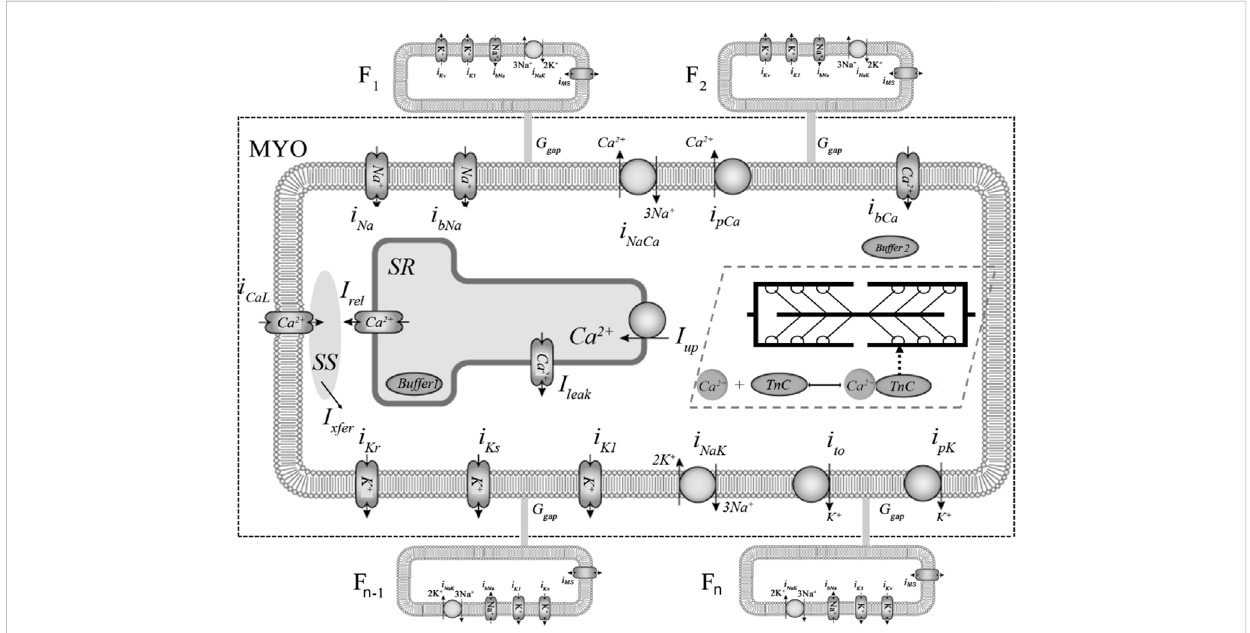
FIGURE 1 Ionic membranecurrents and intracellular calcium homeostasisin the TP + M and fi broblast models. The fragment delimited bydashed rectangular box represents theelectrophysiologicalpart ofthecombined TP+ M model. The fi broblasts arelabelled F 1 , F 2 , ... ,F n-1 , F n .Calcium currents:L-typeCa 2+ current ( i CaL ) and background Ca 2+ current ( i bCa ). Potassium currents: inward recti fi er K + current ( i K1 ); transient outward current ( i to ); rapid and slow delayed K + recti fi er current ( i Kr , i Ks ); plateau K + current ( i pK ). Sodium currents: fast Na + current ( i Na ) and background Na + current ( i bNa ). Pumps and exchangers: sarcolemmal Ca 2+ pump current ( i pCa ); Na + -K + pump current ( i NaK ) and Na + -Ca 2+ exchanger (NCX) current ( i NaCa ). Calcium translocations: Ca 2+ release from the sarcoplasmic reticulum (SR) via ryanodine receptors into subspace (SS) ( I rel ); Ca 2+ diffusion from SS into cytoplasm ( I xfer ); a small Ca 2+ leakfromintoSRintocytoplasm ( I leak );Ca 2+ pumpingfromthecytoplasm to theSR( I up ),where Ca 2+ ispartiallybuffered (Buffer 1 inSR).Cytoplasmic buffering is divided into two parts: Sa 2+ -troponin C complexes (CaTnC) and buffering by other intracellular ligands (Buffer 2 ).